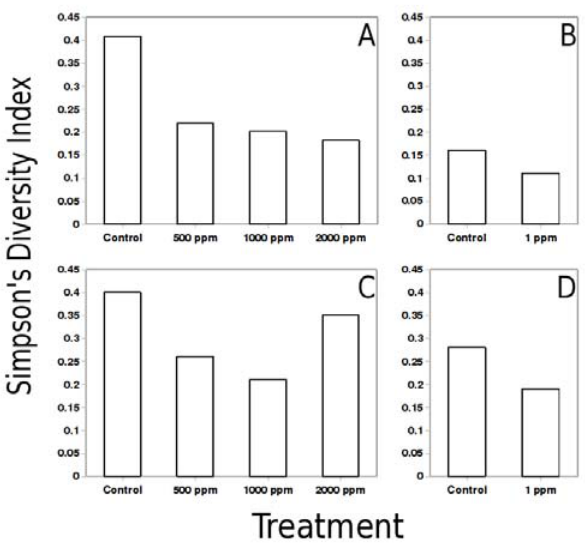
Figure 5: Diversity comparison between control and Pb addition samples. Panels A and B, 16S Simpson's diversity coefficients for high and low Pb, respectively; C and D, nirK diversity for high and low Pb,